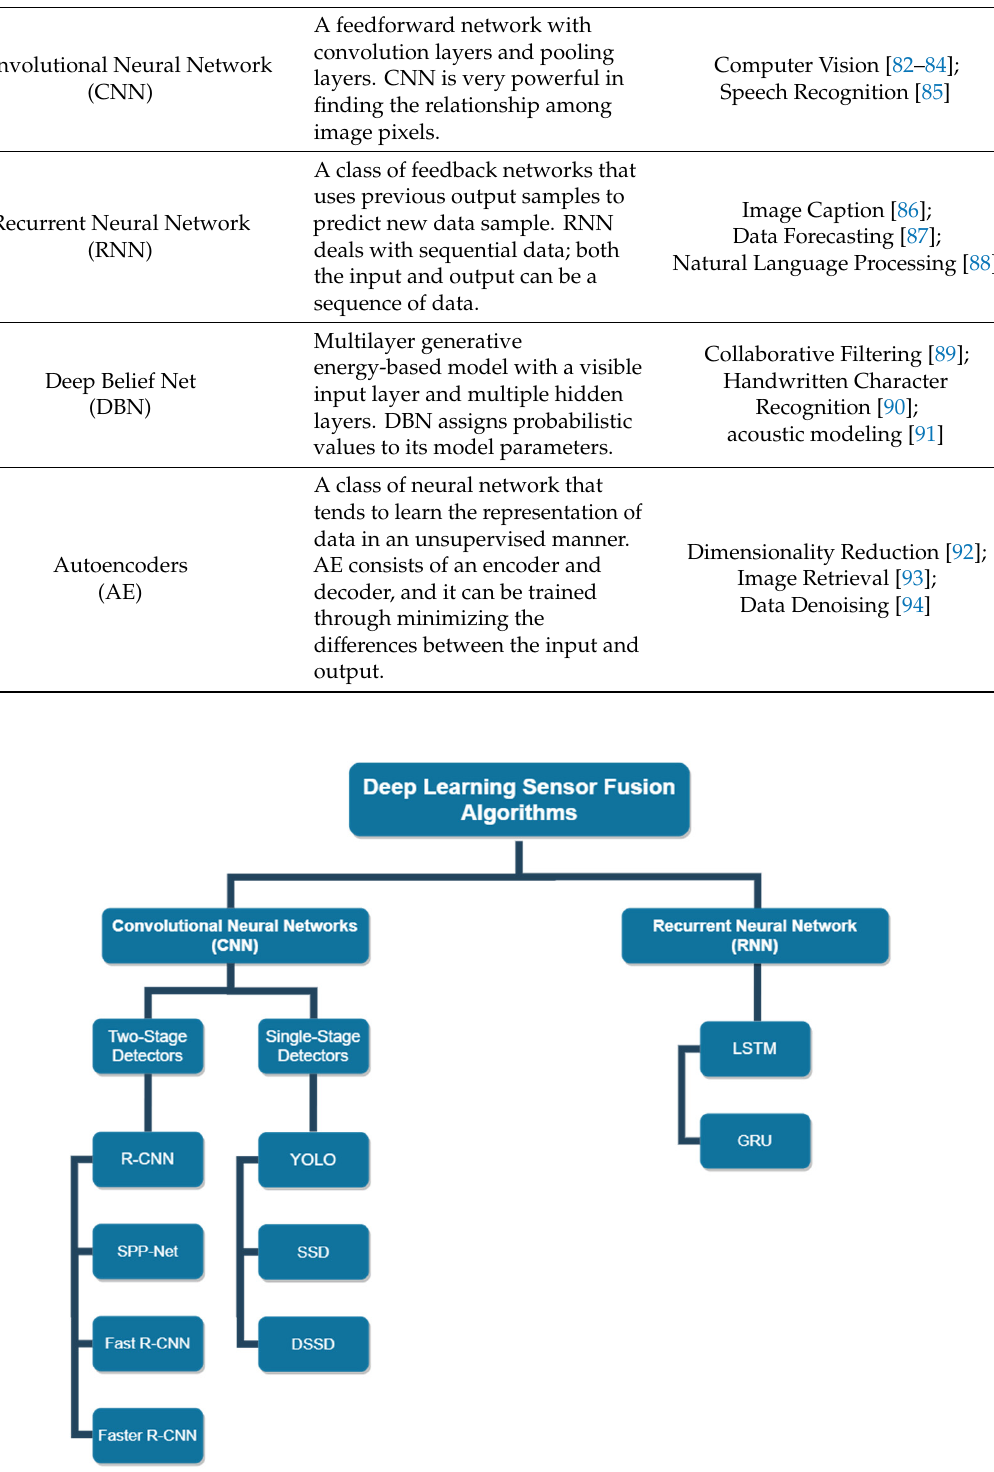
Figure 7. Common deep learning sensor fusion algorithms used in autonomous vehicle